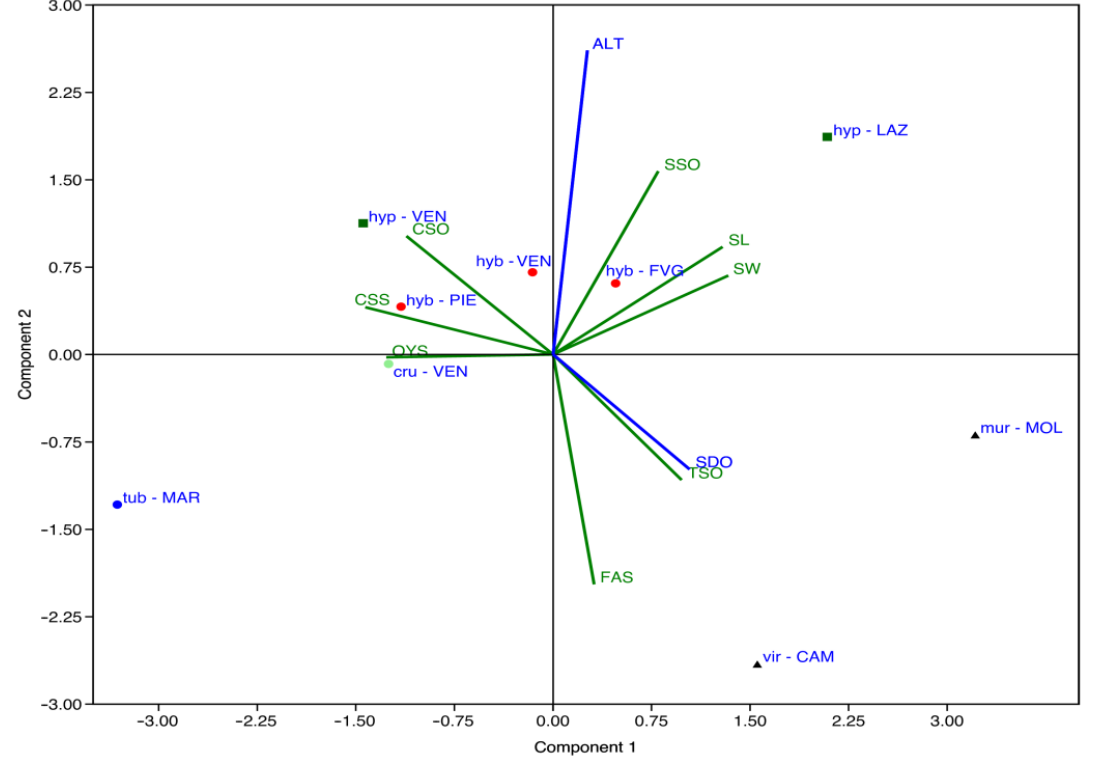
Figure 2. Scatterplot of the first two principal components from the PCA was carried out with 10 variables and 9 samples. Blue line: ALT (altitude); SDO (seed color); green line: OYS (oil yield in seed); CSO (conc. squalene in oil); CSS (conc. squalene in seed); TSO (tocopherols in seed oil); SSO (sterols in seed oil); FAS (free fatty acids in seed oil); SL (seed length); SW (seed width).